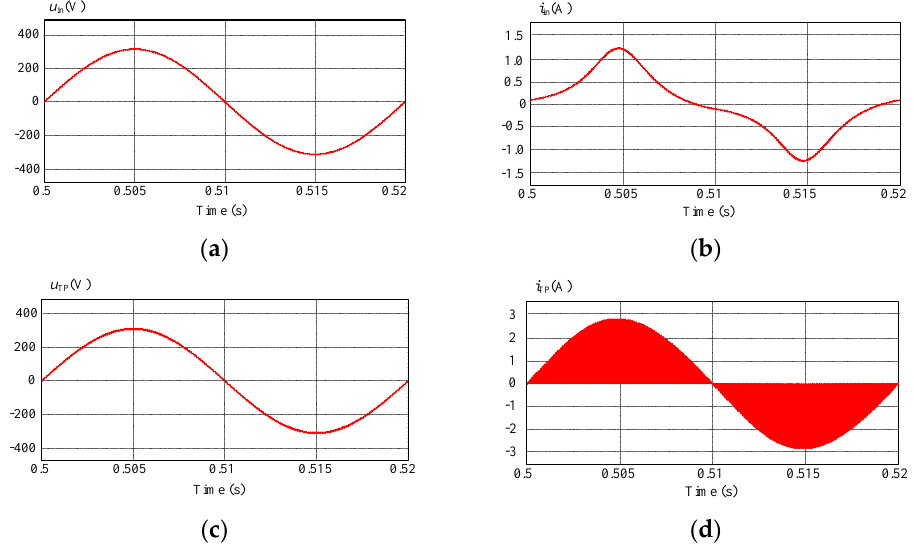
Figure 15. The simulation waveforms. ( a ) Input voltage u in . ( b ) Input current i in . ( c ) PFC input voltage u TP . ( d ) PFC input current i TP .